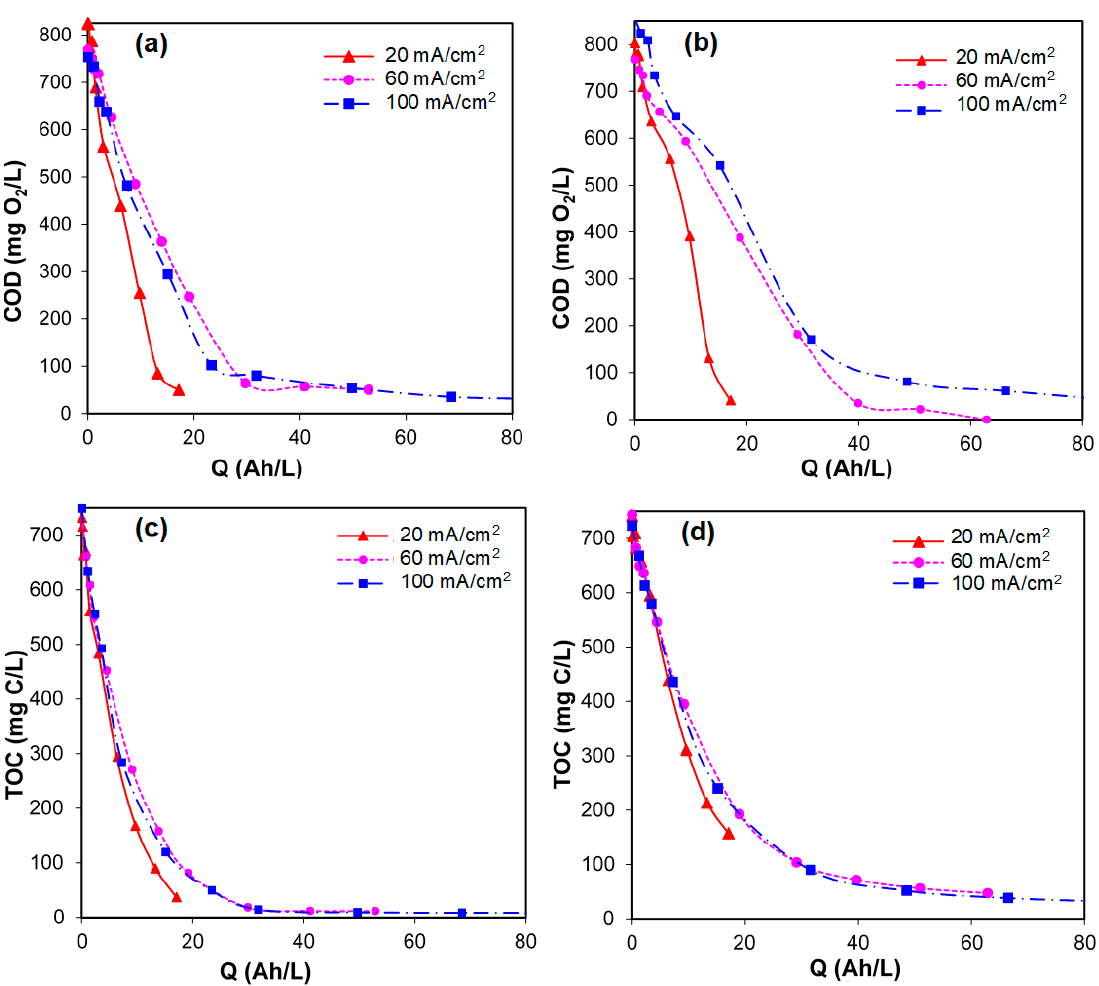
Figure 2. Changes of COD ( a , b ) and TOC ( c , d ) with the specific electric charge during electrolytic treatment of synthetic urine of pH 5.5 at room temperature (25 °C) using BDD ( a , c ) and DSA ( b , d ) anodes and a stainless steel cathode with a flow rate of 800 mL/min at different current densities: ( ▲ ) 20 mA/cm 2 , ( ● ) 60 mA/cm 2 , and ( ■ ) 100 mA/cm 2 .